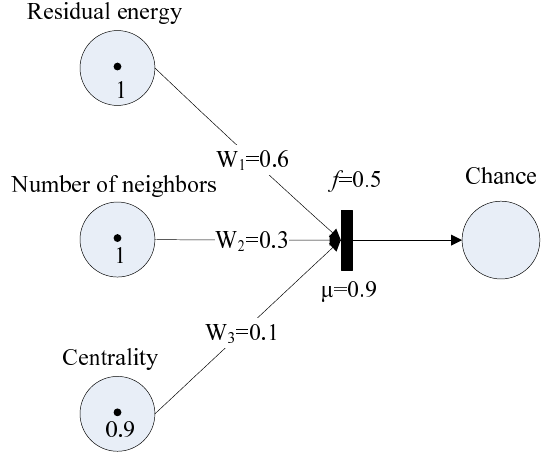
Figure 6. An example fuzzy Petri nets model for a cluster head election